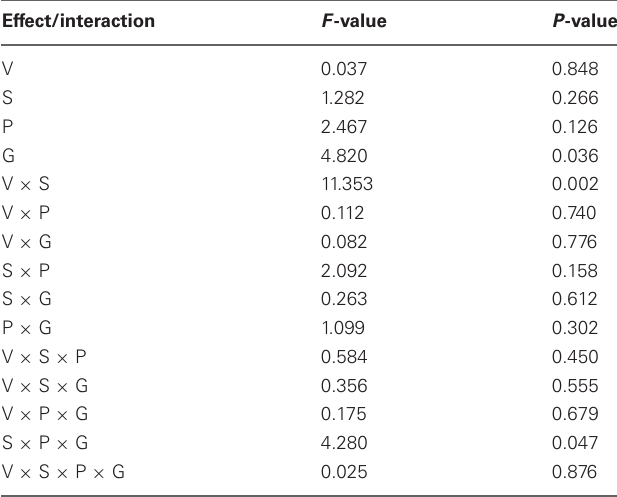
Table 6 | Modulation of frontoinsular cortex component activity by task.